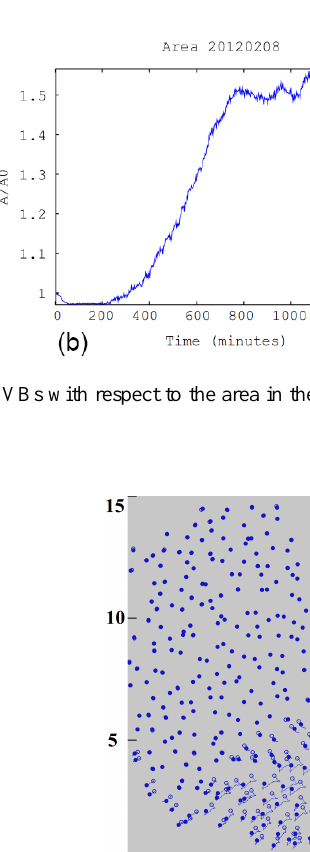
Figure 12. Velocity (a) and direction (b) for the 2012 case selected three VBs. The direction is in degrees.